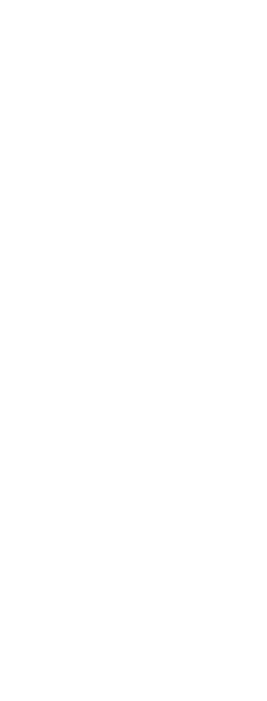
Comparison between de-implementation strategy 1 and 2